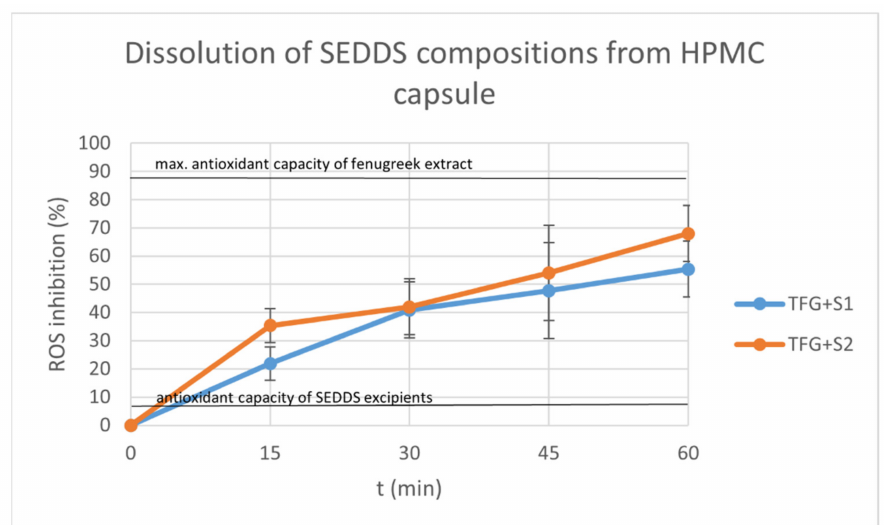
Figure 11. Dissolution of TFG + S1 and TFG + S2 from HPMC capsule over time. Each data point represents the mean ± S.D. inhibition percentage of 5 independent parallel dissolution test